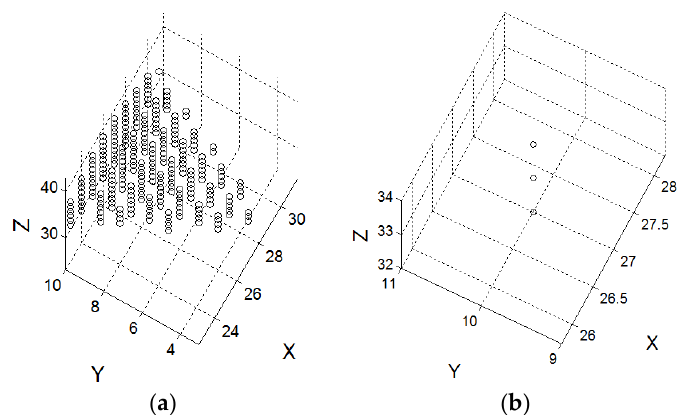
Figure 4. An example of removing all voxels of pyramid structure by the fully parallel thinning algorithm. ( a ) A portion of a manta ray model’s wing; ( b ) A result after eight iterations of thinning procedures.